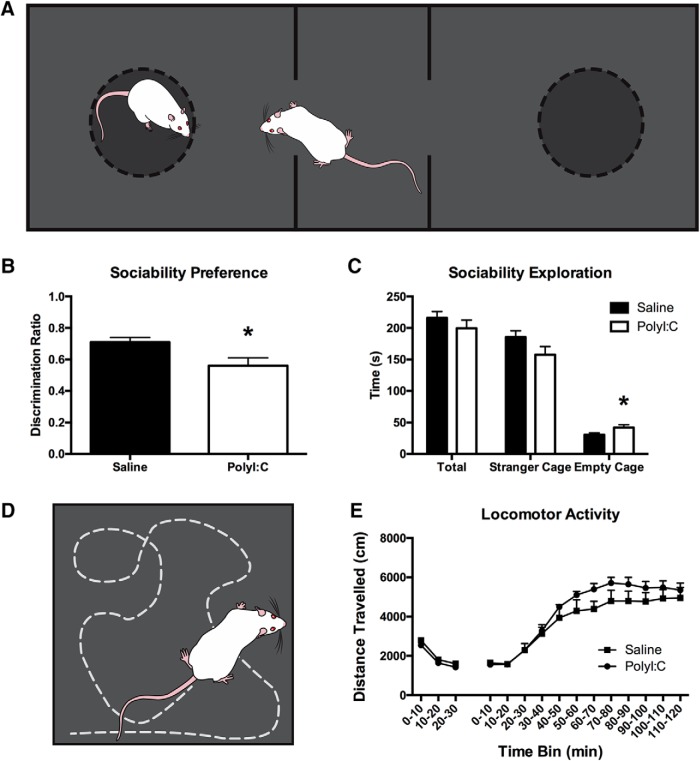
A, Schematic representing the black, three-chambered arena used to conduct the sociability task. The chambers on either side of the center start chamber contain identical holding cages, one of which would contain a social stimulus (an age, sex, and treatment matched stranger rat), while the test rat was free to explore. Schematic has been published previously (Henbid et al., 2017; Lins et al., 2018). B, When the exploration data are presented as a DR, both groups show significant preference for the stranger rat; however, polyI:C offspring show significantly less preference when compared to saline offspring. C, There was no significant difference between groups in total exploration or exploration of the social stimulus, although polyI:C rats spent more time exploring the non-social stimulus than saline rats. D, Schematic of the black, square arena where rats’ activity was monitored before and after administration of MK-801. Schematic has been published previously (Lins et al., 2018). E, Graph displaying locomotor activity as distance traveled per 10 min time bin. Both groups had elevated locomotor activity following MK-801 administration, but there was no effect of maternal treatment. *p < 0.05.